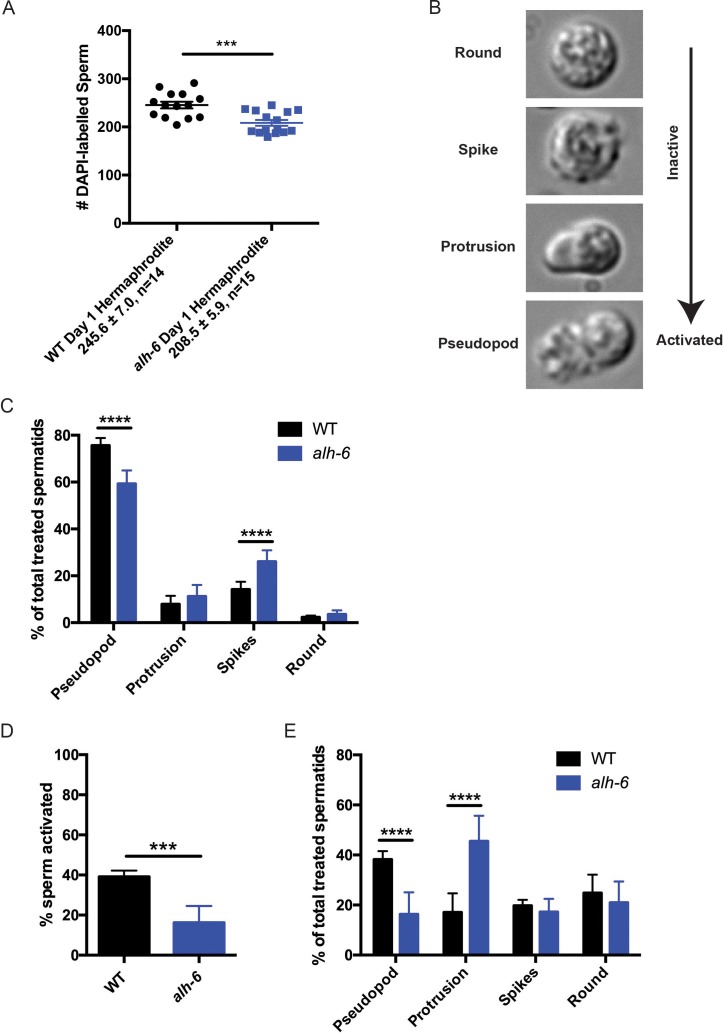
Activation defects of alh-6 spermatids.(A) alh-6 hermaphrodites have reduced sperm number as day one adults. (B) Spermiogenesis stages (round, spike, protrusion, pseudopod). Spermatozoa with fully formed pseudopods are considered activated in Pronase and Monensin experiments. (C) alh-6 male spermatids treated with Pronase are stalled at the ‘spikes’ stage compared to WT male spermatids. (D) alh-6 male spermatids treated with Monensin have reduced activation compared to WT male spermatids. (E) alh-6 male spermatids treated with Monensin are stalled at the ‘protrusion stage’ compared to age-matched WT spermatids. Statistical comparisons of sperm number by unpaired t-test and sperm activation by Fisher’s exact test. *, p<0.05; **, p<0.01; ***, p<0.001; ****, p<0.0001. All studies performed in at least biological triplicate; refer to Supplementary file 1 for n for each comparison.